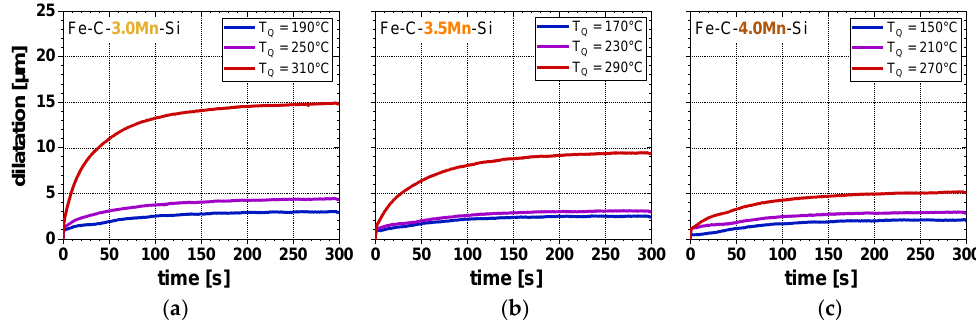
( c ) Figure 2. Dilatometric curves for the ( a ) Fe-C-3.0Mn-Si, ( b ) Fe-C-3.5Mn-Si, and ( c ) Fe-C-4.0Mn-Si steels quenched to different T Q in order to adjust 50 vol.% (red), 75 vol.% (purple) and 85 vol.% (blue) α’ prim . It is obvious from these dilatometric curves that during isothermal holding at T P γ partially transformed to α B , accompanied by a linear expansion. Figure 3 gives a detailed perspective on the